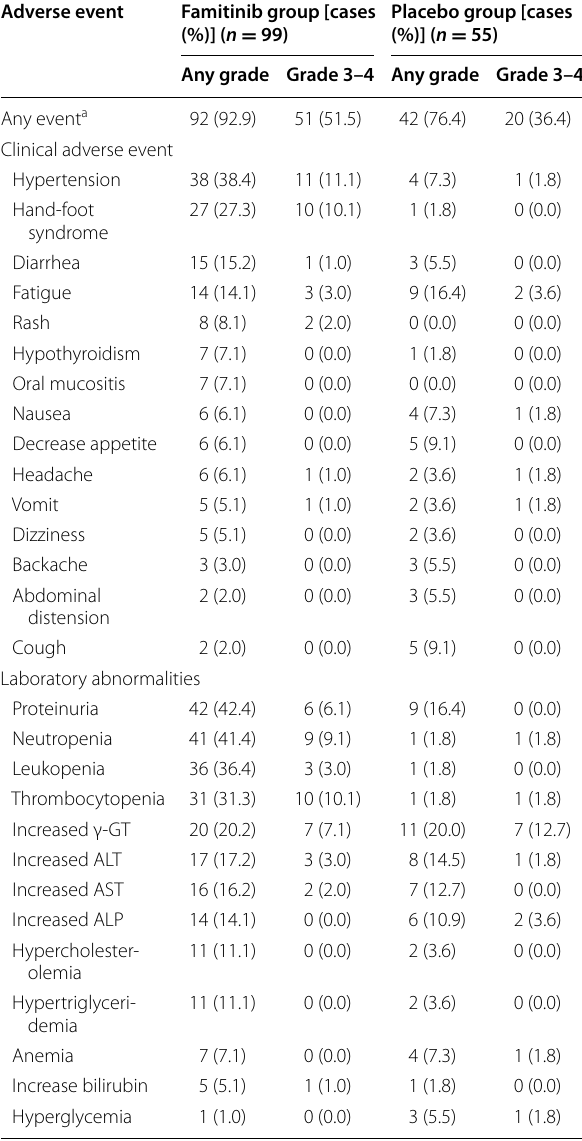
standard deviation ±